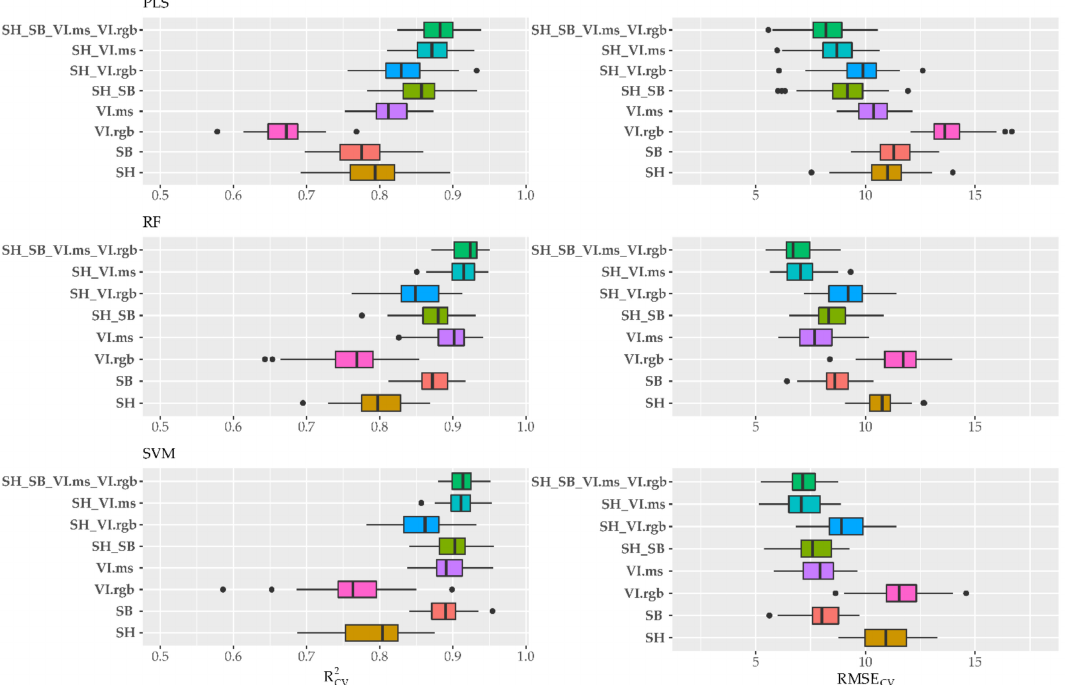
Figure 18. Box and whisker plot of R 2 CV and RMSE CV (N uptake kg ha − 1 ) of all resamples of RF, SVM, and PLS models for N-uptake prediction (SH: sward height metrics. SB: single bands, VI.rgb: RGB indices, VI.ms: VNIR indices).